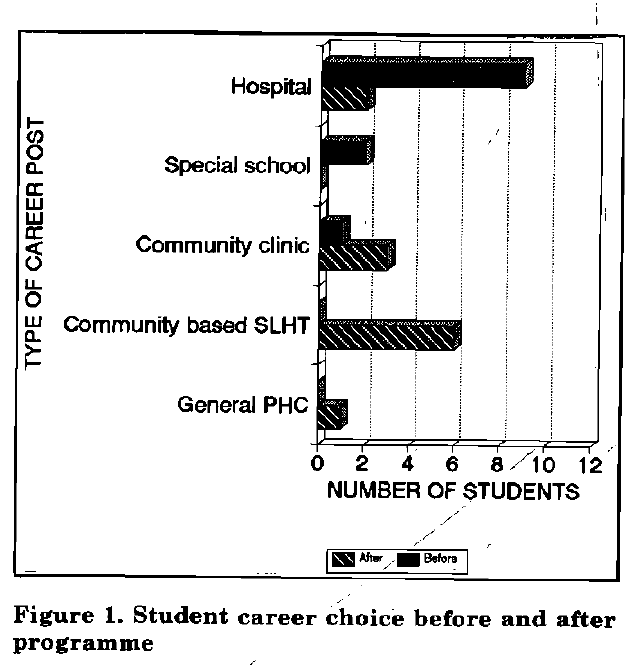
Figure 1. Student career choice before and after